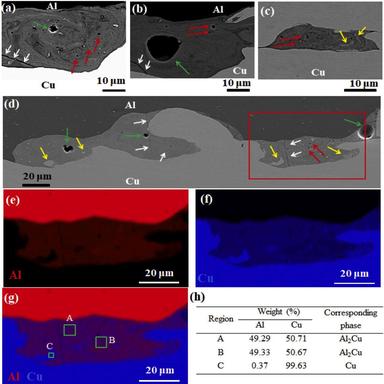
Microstructures of the IM layers showing (a) swirling and porous structures; (b) microscale cavity; (c) adjacent intermixing zone with micro porous structures; (d) microcracks bounded in the IM layers; (a), (b), (c) and (d) are taken from the areas A, B, C and D marked in, respectively. The microscale pores, microcracks and Cu fragments are highlighted by green, white and yellow arrows, respectively. EDS analysis: (e) Elemental map of Al, (f) Elemental map of Cu, (g) Elemental map of Al and Cu,